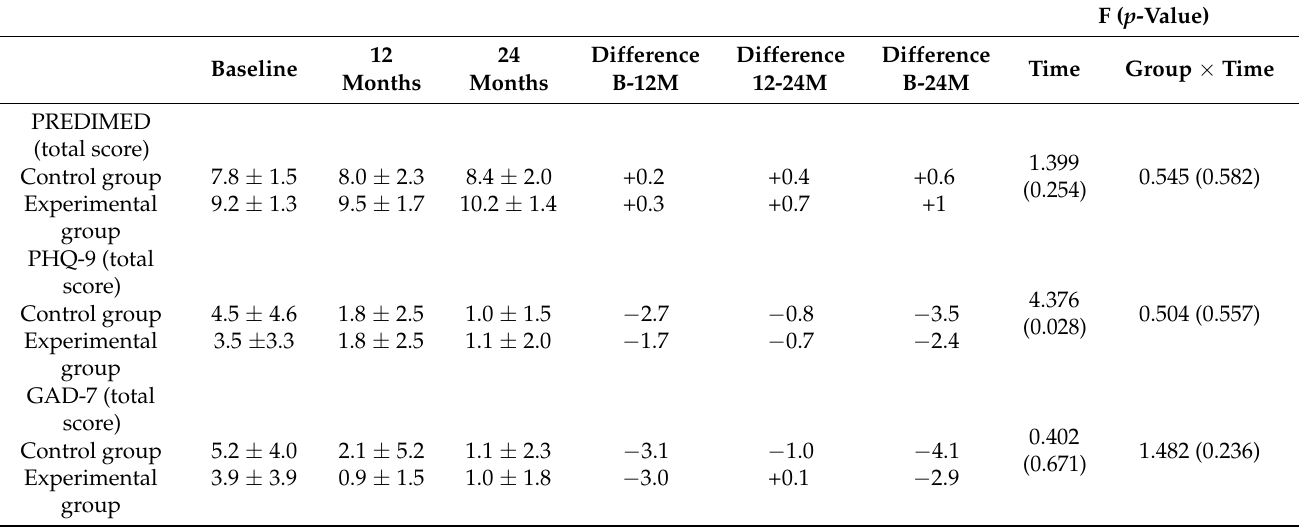
Table 5. Changes in the scores of the PREDIMED, PHQ-9, and GAD-7 questionnaires.